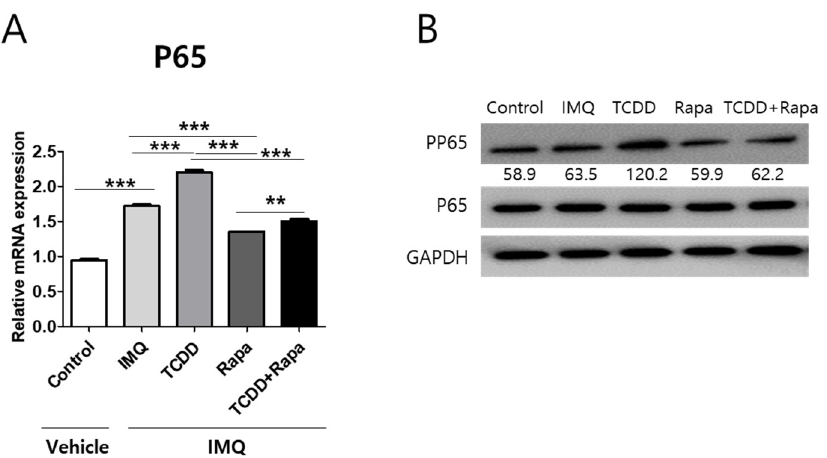
Figure 9. The effects of TCDD, rapamycin, or a combination of both on P65 mRNA and phosphorylation of P65 expression changes in mouse skin tissue. ( A ) qPCR of P65 and ( B ) Western blot analysis of phosphorylation of P65 expression in mouse skin from 5 different treatment regimens ( n = 5 per group). Data represent the mean ± SD of three independent experiments (each performed in duplicate). Statistical differences were determined by one-way analysis of variance (ANOVA) followed by post hoc Dunnett’s test. ** p < 0.01; *** p < 0.001. Western blot normalization was based on GAPDH. Western blot data are representative of three independent experiments. IMQ: imiquimod, Rapa: